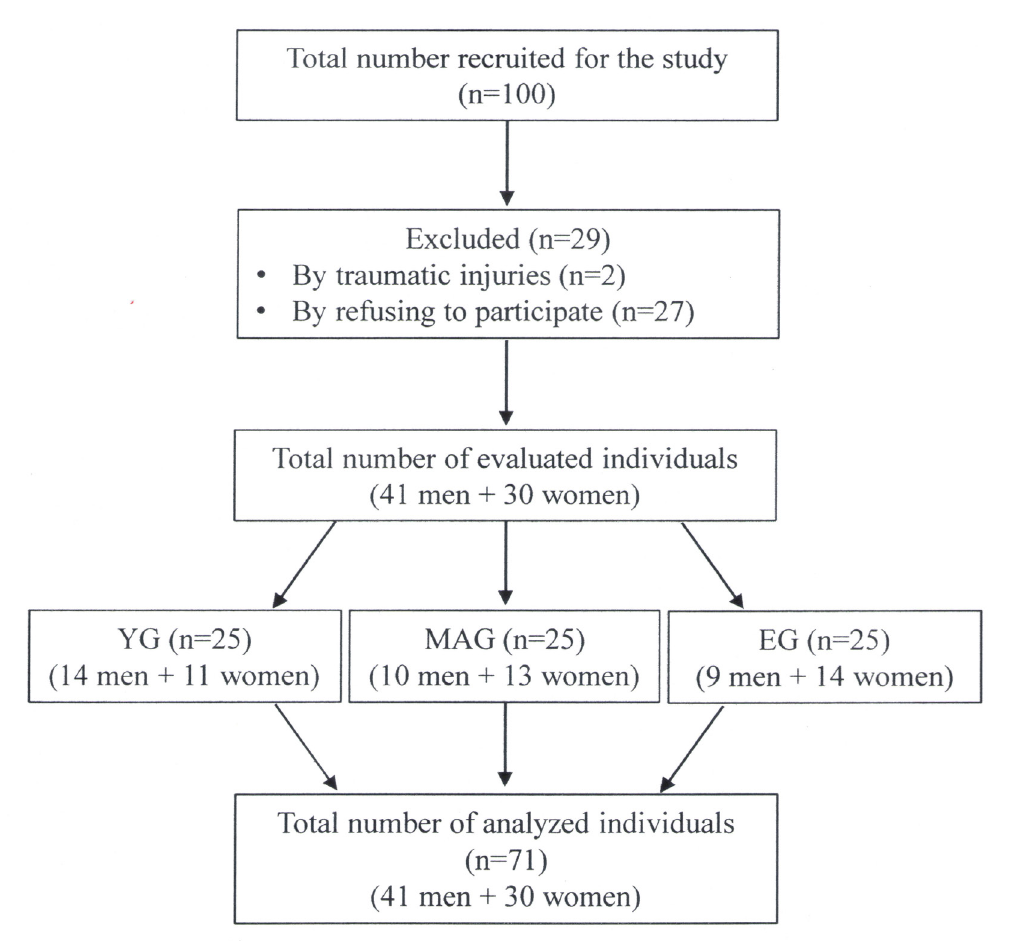
Figure 1. Flow diagram of the